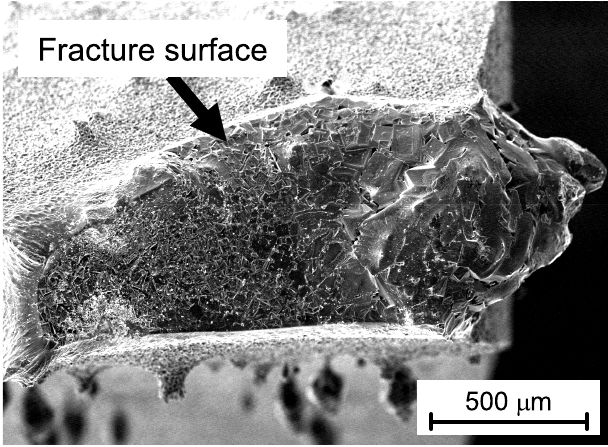
FIG. 14. SEM image of fracture surface at cutoff point.